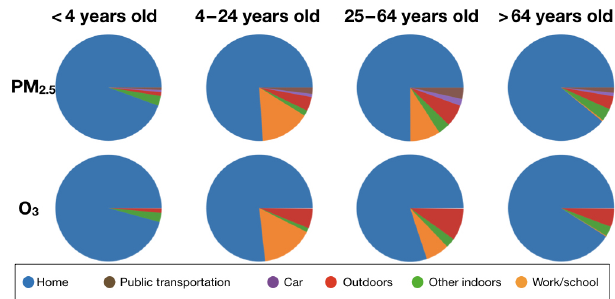
Figure 10. Relative contribution of the different microenvironments in the aggregated daily exposure depending on the age